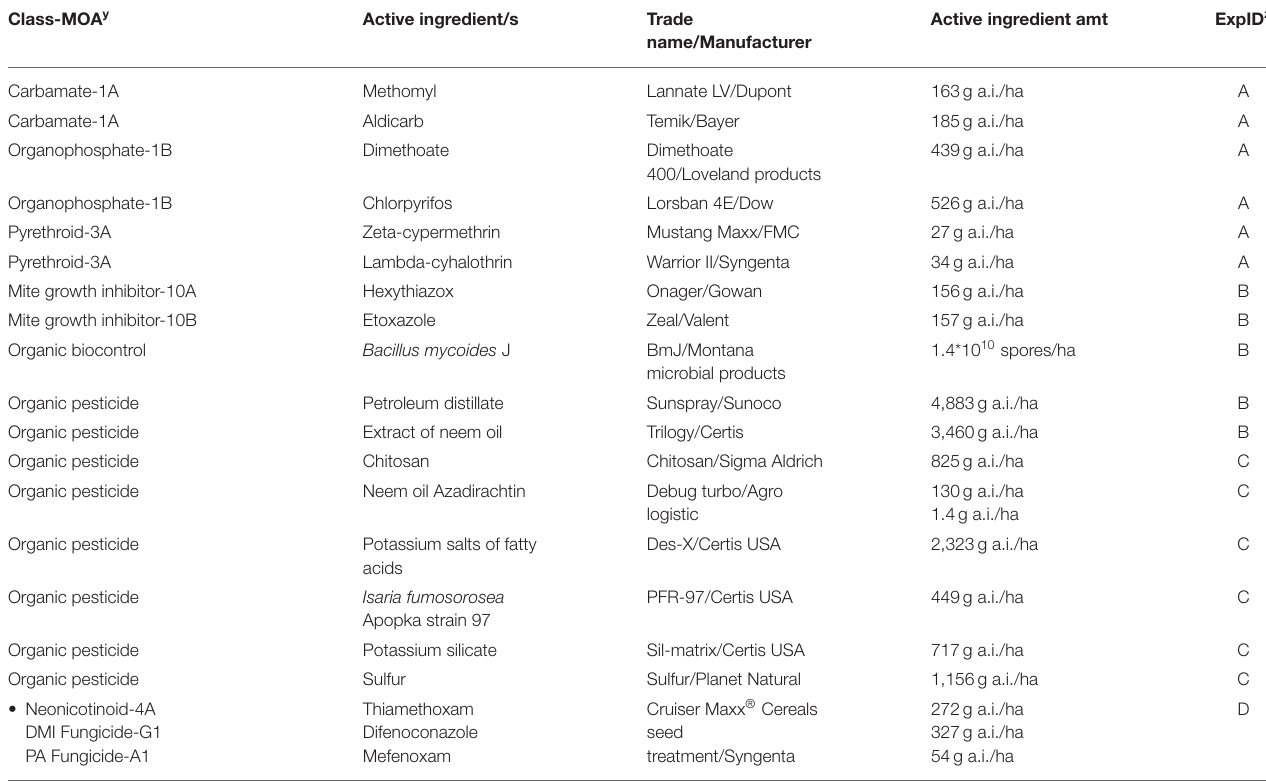
TABLE 1 | Products selected for WCM insecticide efficacy